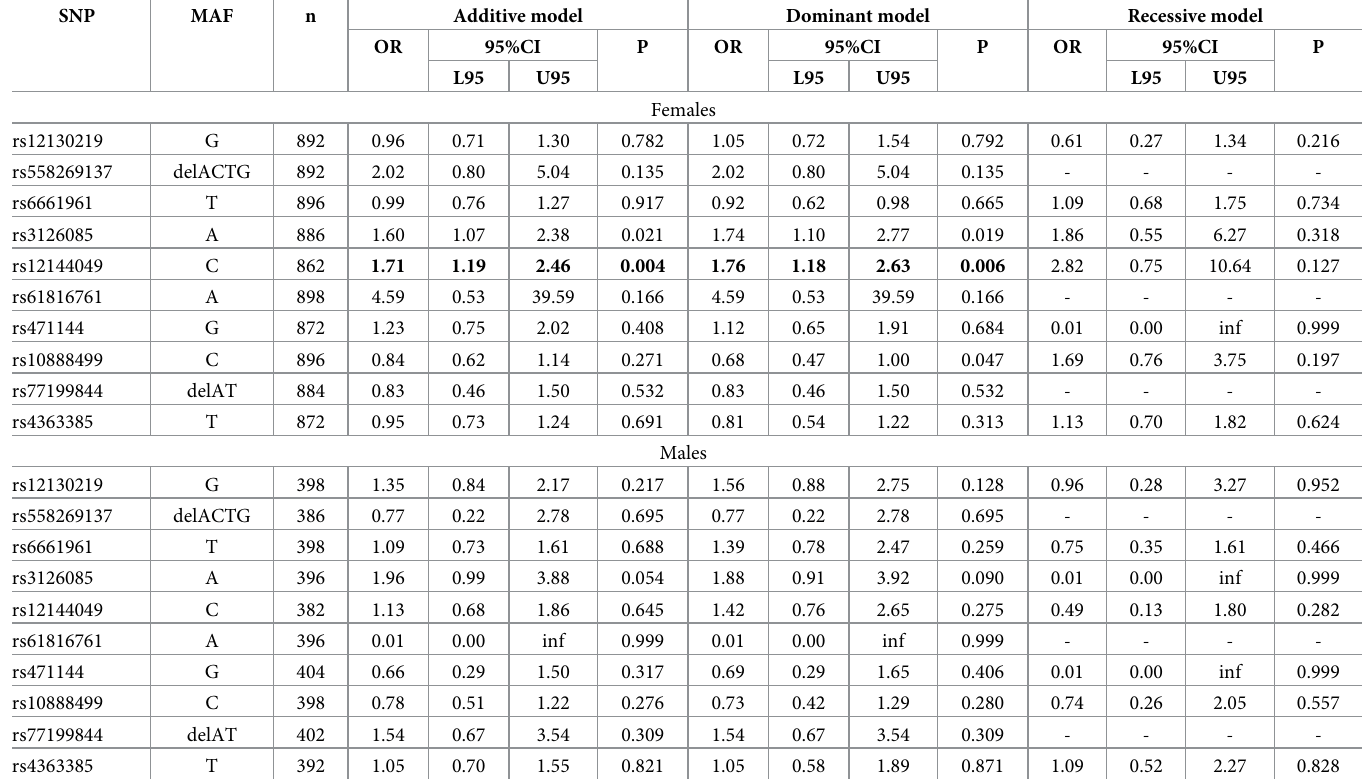
Table 2. Associations of the FLG gene polymorphisms with AD in females and